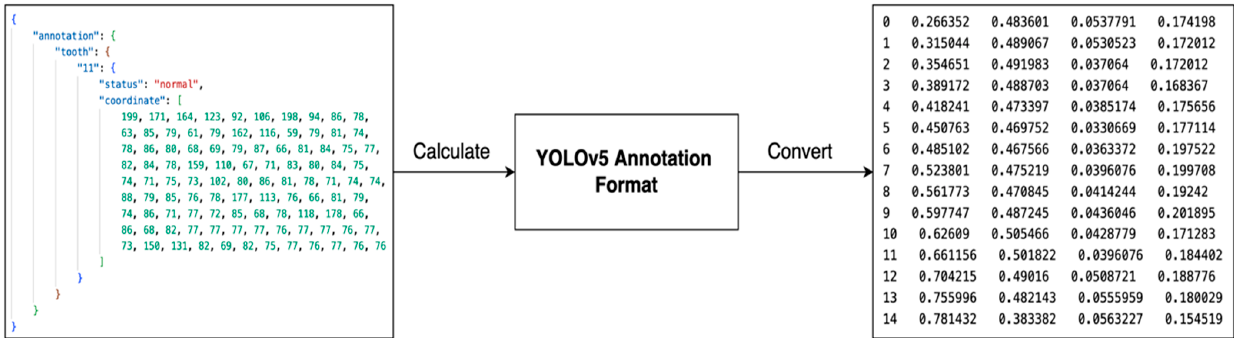
Figure 6. Annotation conversion from JSON to YOLOv5 for AIHub and CBNUH data integration.